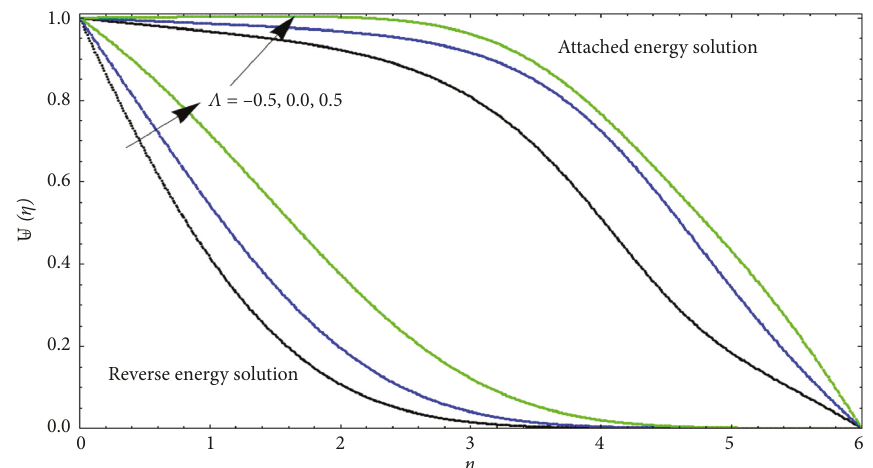
Figure 7: Dissimilarity of ⊎ ( η ) being some different values of Λ and Pr � 1 for two solutions AFS and